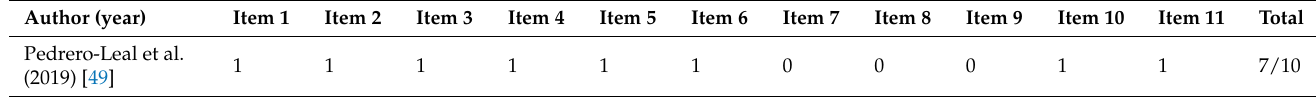
Table 4. Quality of the case studies, as measured by the SCED